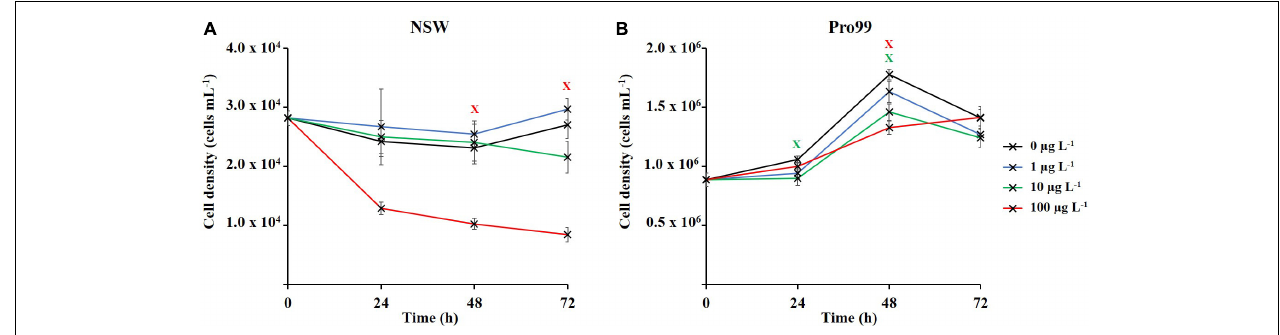
FIGURE 2 | Seventy-two hours exposure of Prochlorococcus sp. MED4 to nCeO 2 (0–100 µ g L − 1 ) in (A) natural oligotrophic seawater, and (B) nutrient-rich Pro99 media. Data points represent the mean of three culture replicates ± standard error ( n = 3). Crosses indicate where Dunnett’s T -tests revealed cell density to significantly vary from the untreated control ( p <